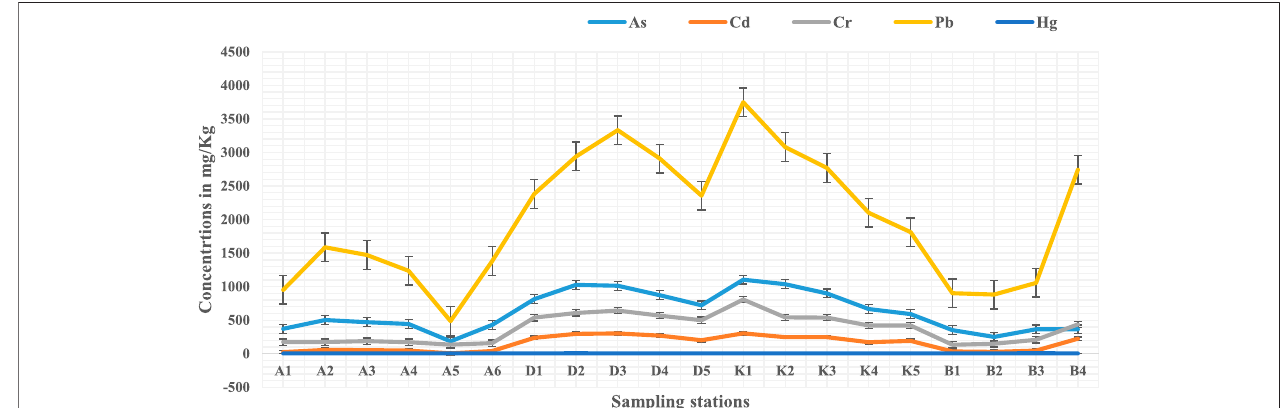
FIGURE 5 | The results of CF (A) and PLI (B) in sampling stations of the study area.